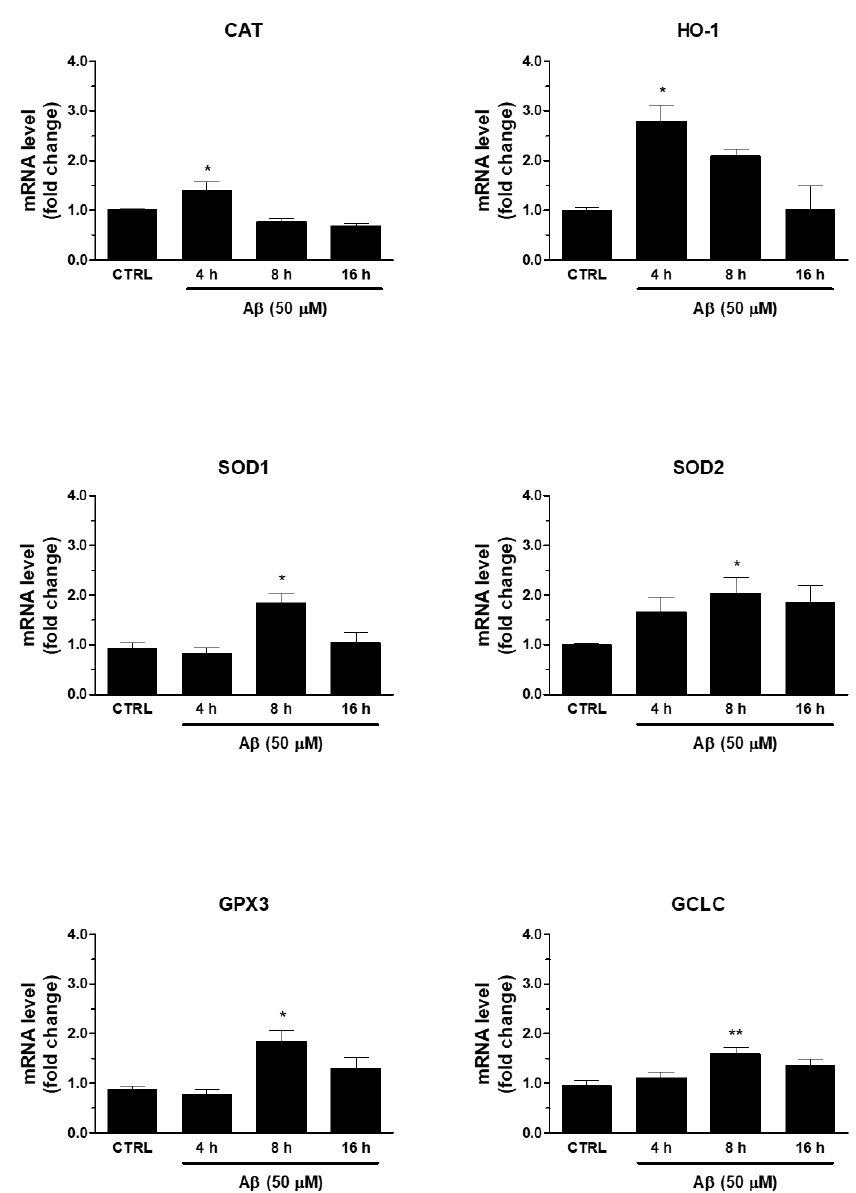
Figure 2. Effects of A β 25-35 on ARE-dependent gene expression in U373 cells. Cells were treated with A β 25-35 (50 µ M) for 4, 8, and 16 h. The samples were then analyzed by RT-qPCR to evaluate the mRNA expression of CAT, HO-1, SOD1, SOD2, GCLC and GPX3 genes. Data are calculated relative to GAPDH content, taken as an internal housekeeping gene. Bars are the means ± SEM from three separate experiments, each carried out in duplicate. One-way ANOVA, followed by Bonferroni’s test, was used to define significant differences. * p ≤ 0.05 vs. CTRL; ** p ≤ 0.01 vs. CTRL.